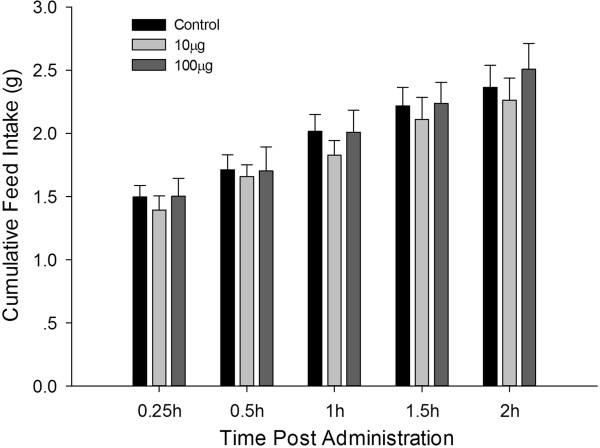
Cumulative feed intake of broiler chicks after ICV administration with saline (control, n = 9), 10 μg (n = 8) or 100 μg (n = 9) L-tryptophan. Feed intake was recorded at 0.25, 0.5, 1, 1.5, and 2 h post-administration; Data are represented as means ± S.E.M.